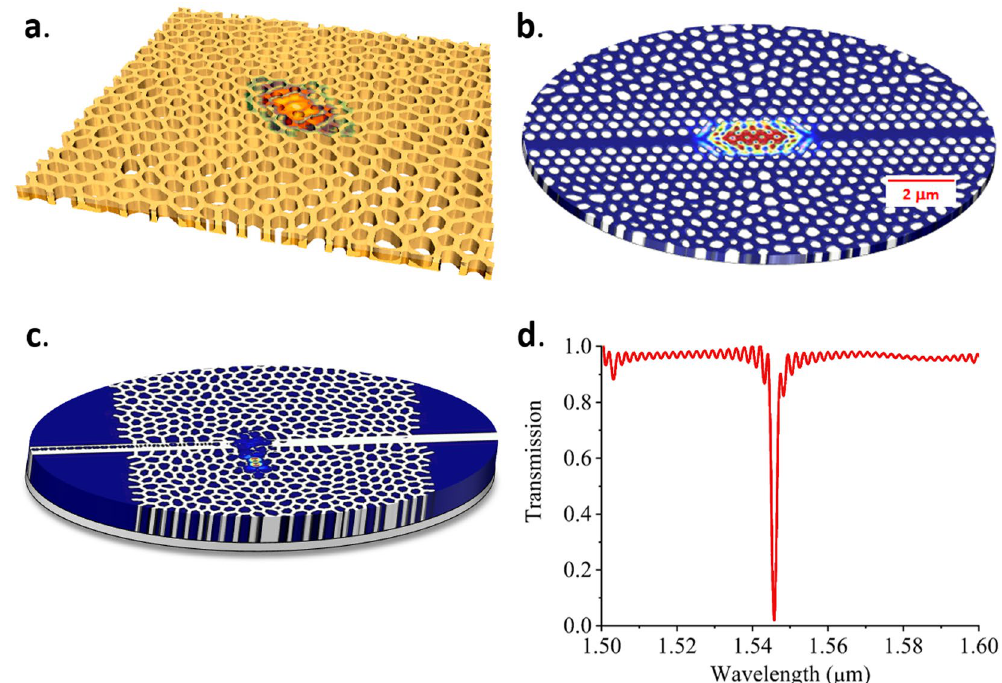
Figure 4. ( a ) Simulated mode field profile for a cavity with a Q-factor larger than 20,000 in a HUDS slab with TE polarization PBG. ( b ) Simulated mode field profile of the HUDS-cladded photonic crystal cavity with a Q factor of 1 million. ( c ) Simulated mode field profile of the resonant mode of a HUDS-based cavity-waveguide filter and ( d ) its simulated transmission